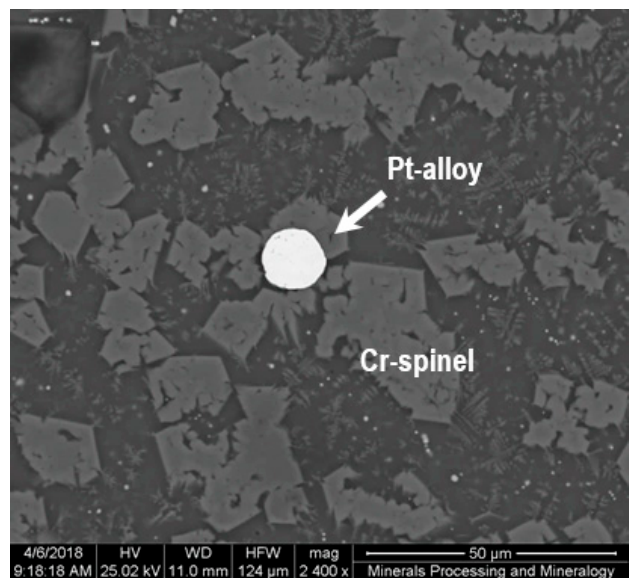
Figure 23. Backscattered electron image of the Platreef product (high sulphide feed) showing a small prill trapped between the spinel crystals. In this case, the spinels are iron-rich.